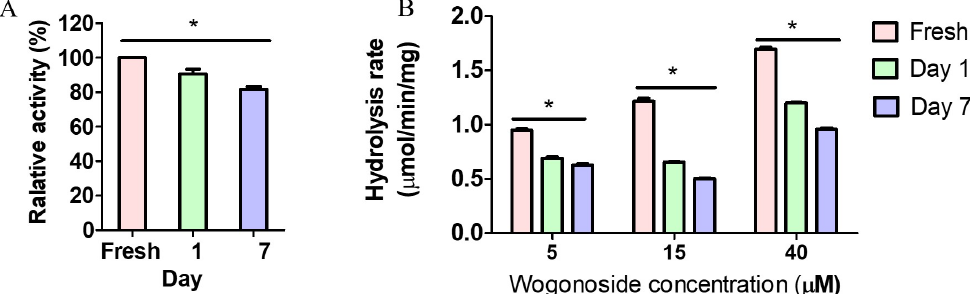
Figure 4. Impact of feces collection time on pNPG ( A ) and wogonoside ( B ) hydrolysis using rat fecal enzyme. The pNPG (final concentration, 1 mM) and/or wogonoside were incubated with the enzymes for 30 min at 37 °C (n = 3, * p < 0.05, One-Way ANOVA). The results showed that activity of fresh feces is better.